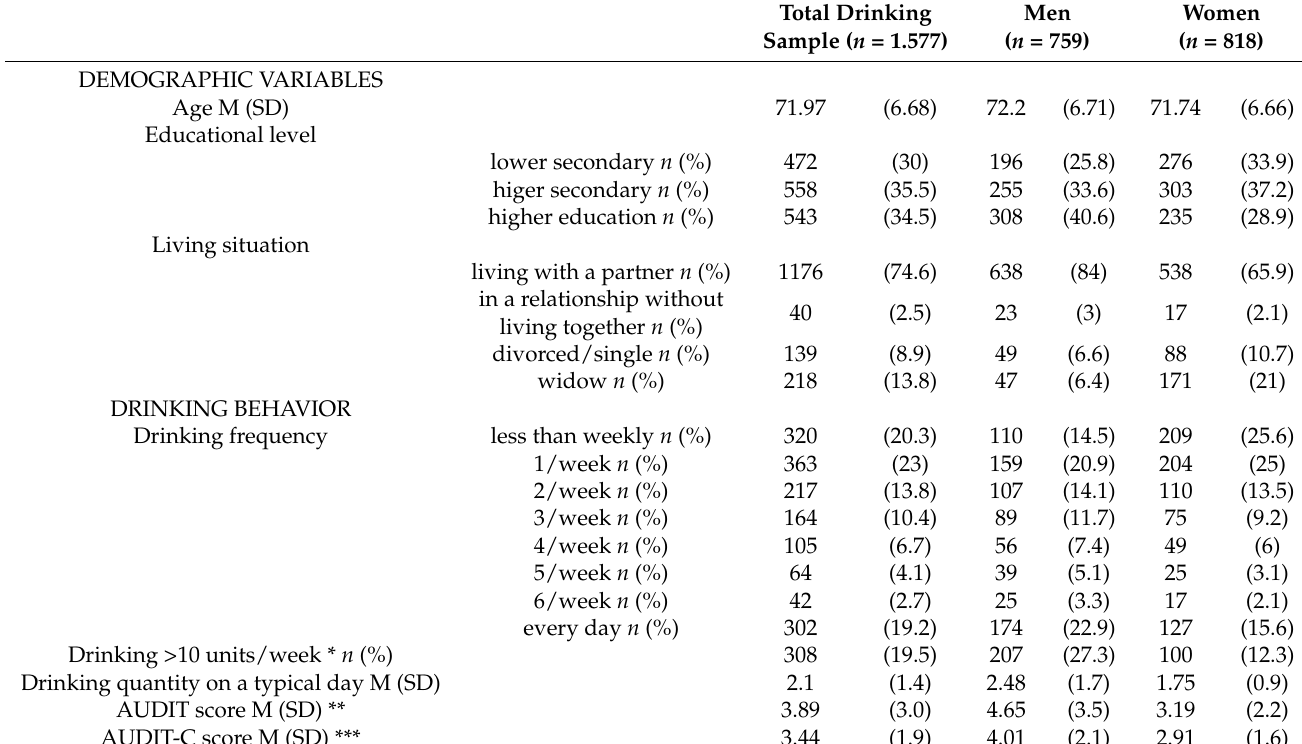
Table 1. Descriptive of the total drinking sample ( n = 1.577) and the gender subsamples.